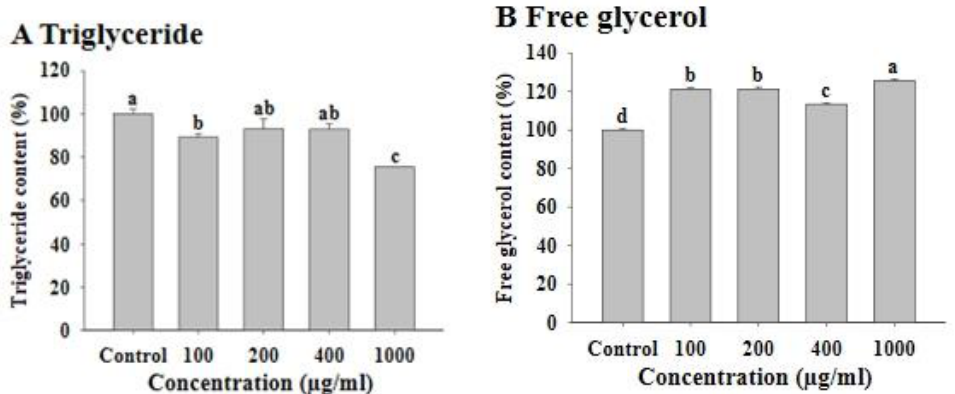
Figure 2. ( A ) Effects of fermented white sword bean extract (FWSBE) on triglyceride accumulation in 3T3-L1 pre-adipocytes. The cells were treated with FWSBE at various concentrations (100, 200, 400, and 1000 µ g/mL) for 48 h during differentiation. The cumulative triglyceride content was measured with the AdipoRed assay. ( B ) Effects of FWSBE on free glycerol in mature 3T3-L1 adipocytes. 3T3-L1 cells (3 × 104 cells/mL) were exposed to different concentrations (100, 200, 400, and 1000 µ g/mL) of FWSBE for 96 h. Values are presented as mean ± standard deviation. The statistically significant difference ( p < 0.05) between groups was determined by a one-way ANOVA and Duncan’s multiple range test. Different letters are indicated as significant